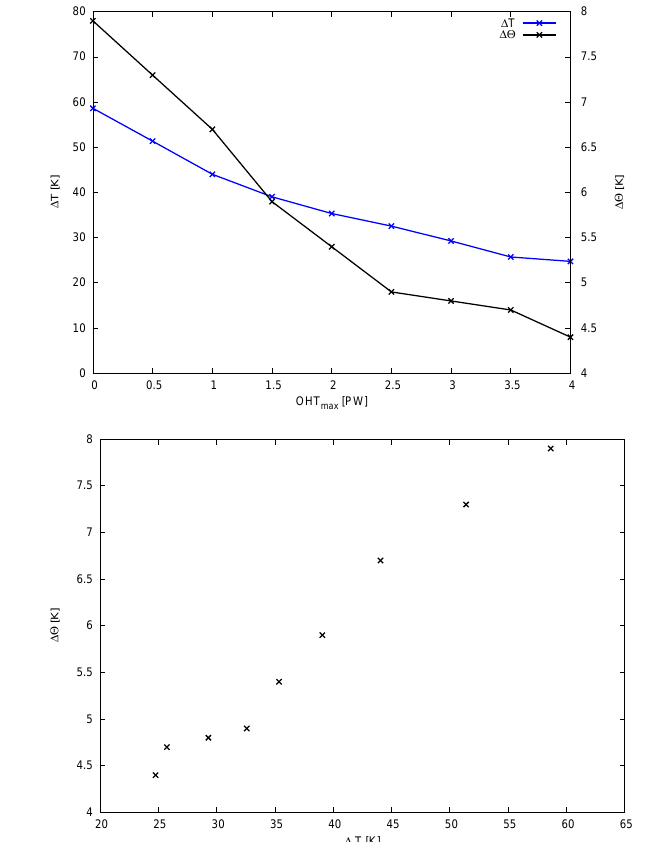
Figure 7. Upper panel: scatterplot of time-averaged global mean near-surface temperature difference between equator and pole (blue) as well as (cid:50) + and (cid:50) − (green) as a function of maximum energy transport in the ocean. Lower panel: scatterplot of time- averaged global mean temperature difference between equator and pole as well as (cid:50) + and (cid:50) − .